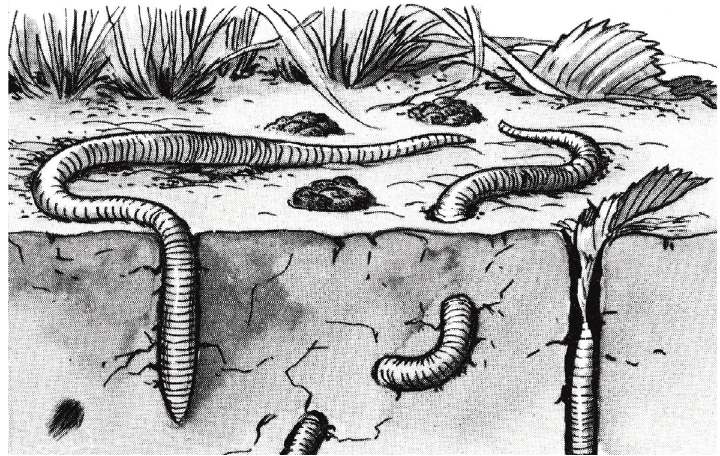
Figure 2: Schematic drawing of common European earthworms ( Lumbricus terrestris ) in their natural habitat. The annelids live in self-made burrows and forage by night on rotten